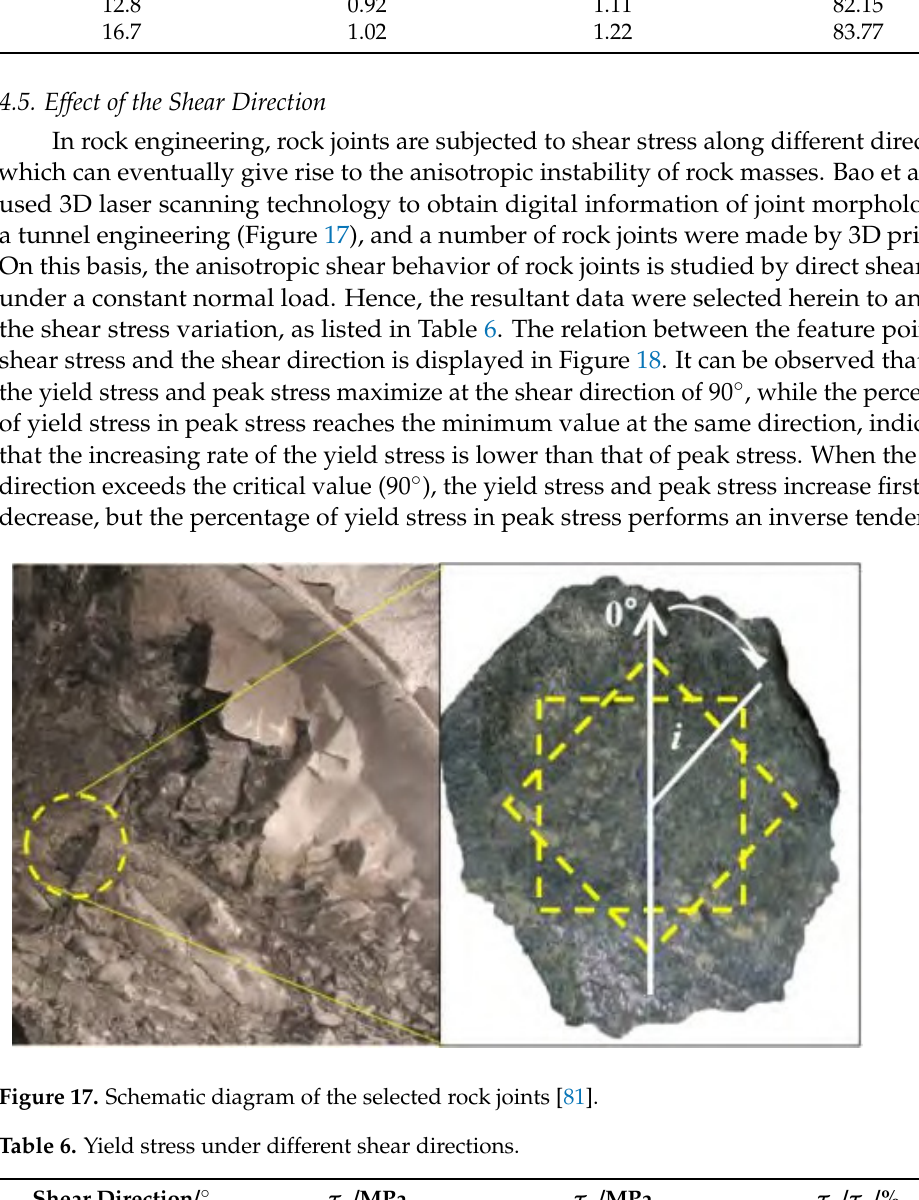
Table 5. Yield stress under various JRC.